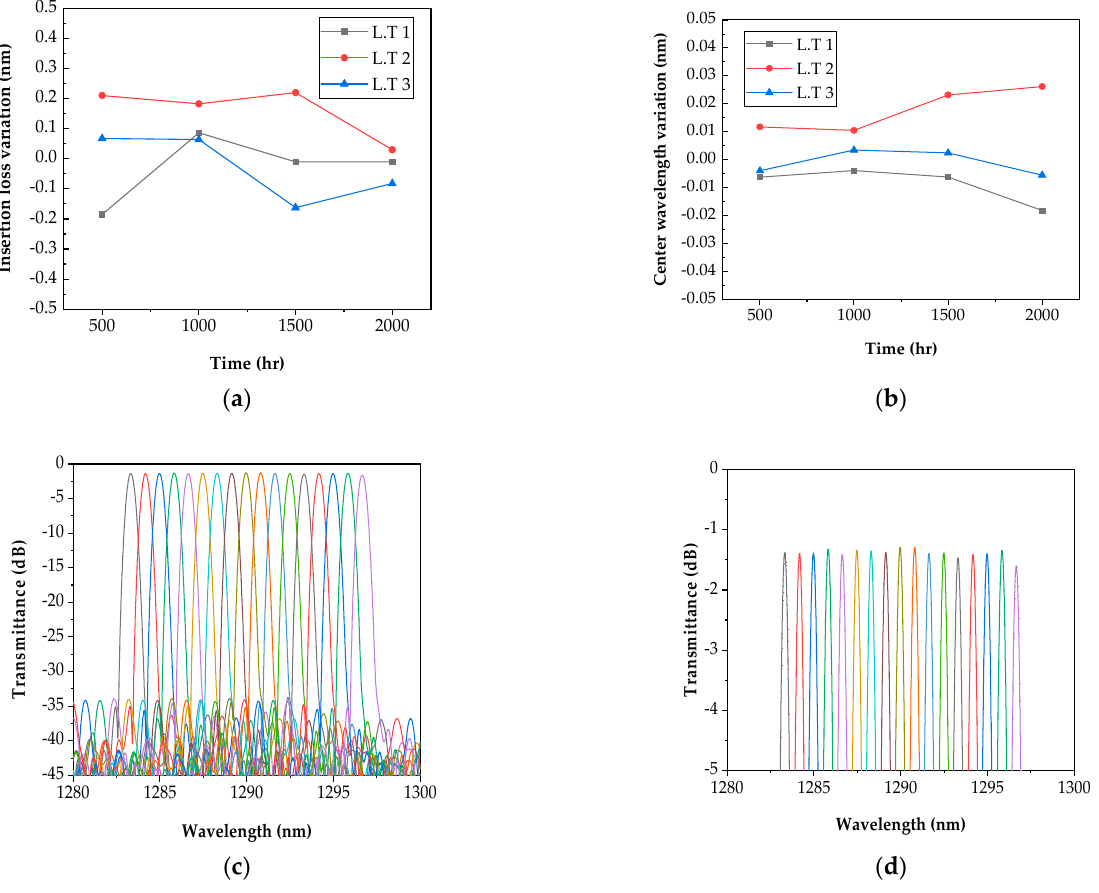
Figure 8. Average results of 17 channels in three AAWG modules after low storage temperature